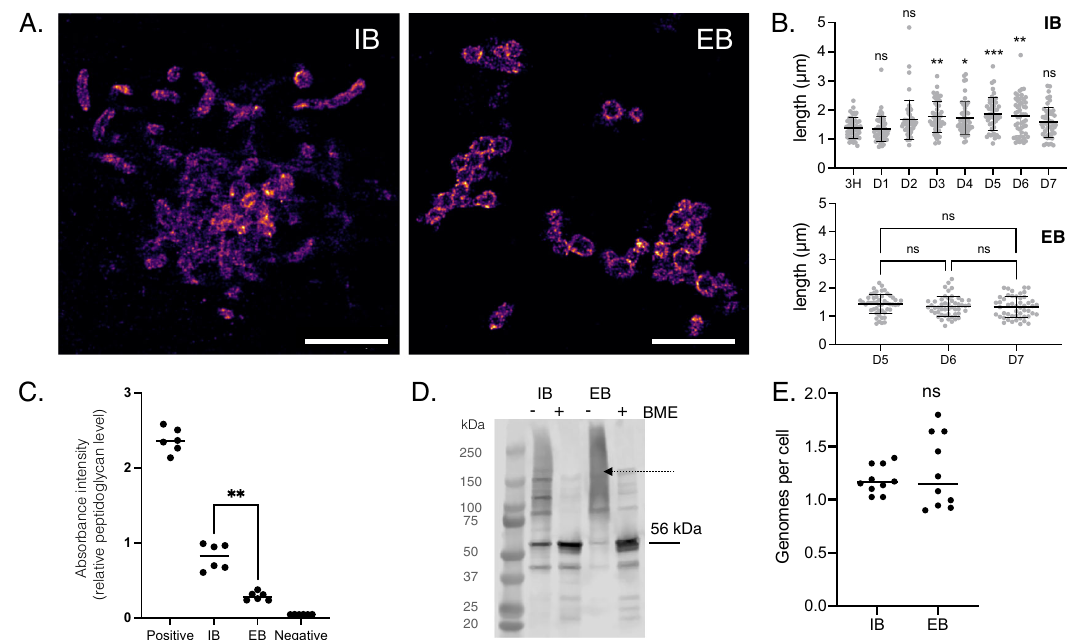
Fig. 1 Intracellular and extracellular forms of Ot are physically distinct. A Representative STORM images of IB (5 d.p.i.) and EB (7 d.p.i.) Ot in L929 cells. Bacteria were labeled with a monoclonal antibody against surface protein TSA56 (magenta). Additional images including DIC images of host cells are provided in Supplementary Fig. 1. Scale bar = 5 µ m. B Length quanti fi cation of individual IB and EB Ot as imaged by STORM. H hours, D days post-infection. The lengths of 50 individual IB (de fi ned as colocalising with host cells) and EB form (de fi ned as not colocalising with host cells) Ot were measured. Statistical signi fi cance was determined using a one-way ANOVA followed by Dunnett ’ s multiple comparisons. n = 50 individual bacteria from one experiment. Data are presented as mean values ± SD. C Quanti fi cation of relative peptidoglycan levels through activation of NOD1 reporter cells, as measured by secreted alkaline phosphatase activity. EB Ot induced less activation than IB, indicating lower levels of peptidoglycan. Identical amounts of IB and EB Ot were used, taken from L929 cells 5 days post-infection. The results of six independent replicates, carried out on two different days, are shown and the statistical signi fi cance was determined using a two-tailed Mann – Whitney test. Positive control = meso-diaminopimelic acid, negative control = PBS. P = 0.0022. D Immunoblot showing the formation of disul fi de crosslinked aggregates of the surface protein TSA56, observed in the absence of the reducing agent betamercaptoethanol (BME). This effect was stronger in EB compared with IB Ot, taken 5 days post-infection from L929 cells. The expected molecular weight of TSA56 (56 kDa) is indicated with an arrow, and a dashed arrow depicts higher-order aggregates. E Genome copy number per cell as measured by qPCR; bacterial cell number was determined by immuno fl uorescence microscopy. Quanti fi cation of 10 individual imaging fi elds is shown, and statistical signi fi cance determined using a two-tailed Mann – Whitney test. n = 10 individual imaging fi elds from one experiment.